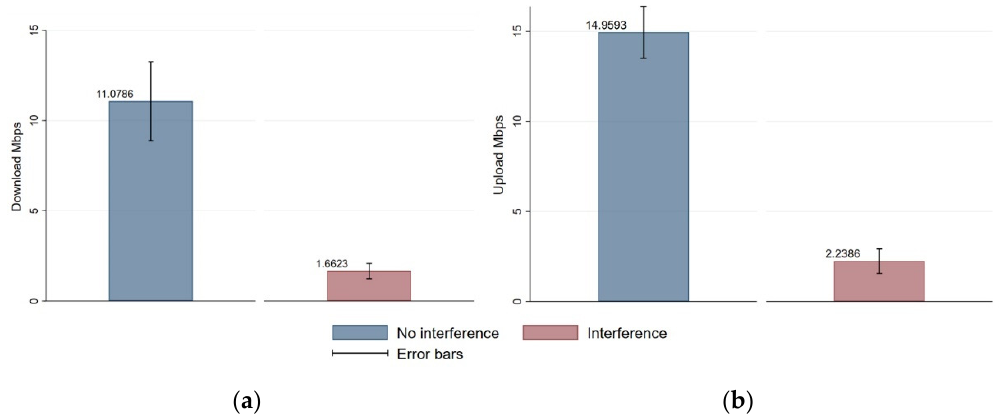
Figure 8. Mean throughput in the absence or presence of interference, based on download ( a ) and upload ( b ). Mean values are shown atop each bar.